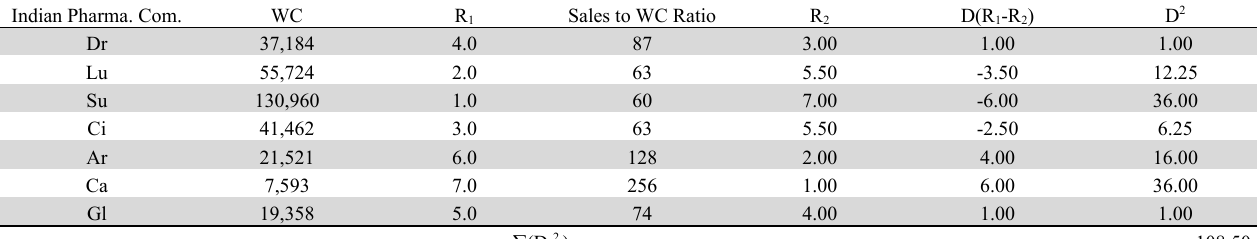
Relational co-movement of working capital and EBIDT to working capital ratio of selected leading pharmaceutical companies of India Indian Pharma.